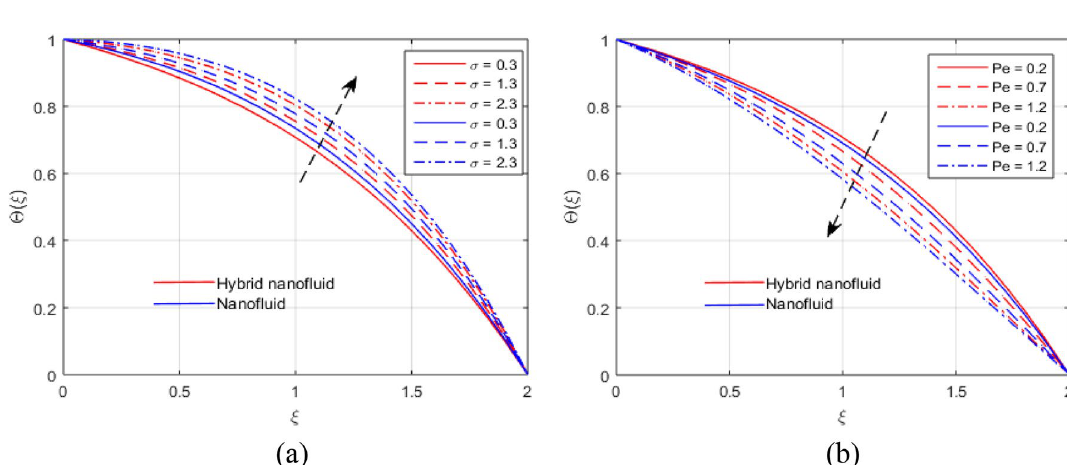
Figure 16. ( a , b ) Effect of σ and Pe on �(ξ)